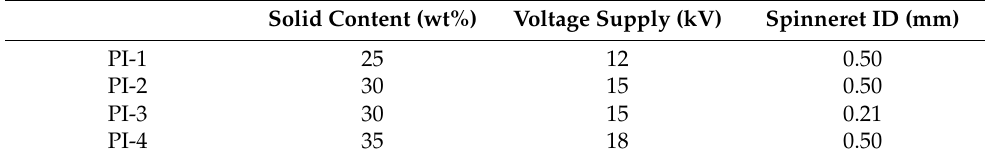
Table 1. Electrospinning parameters of PI NFMs. Solid Content (wt%) Voltage Supply (kV) Spinneret ID